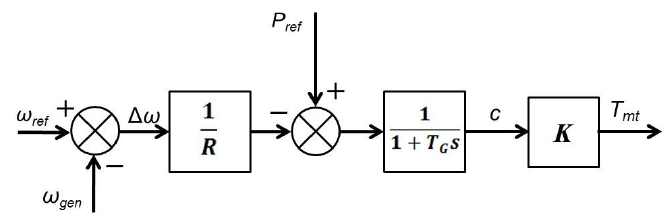
Figure 6. The steam turbine power regulation system.